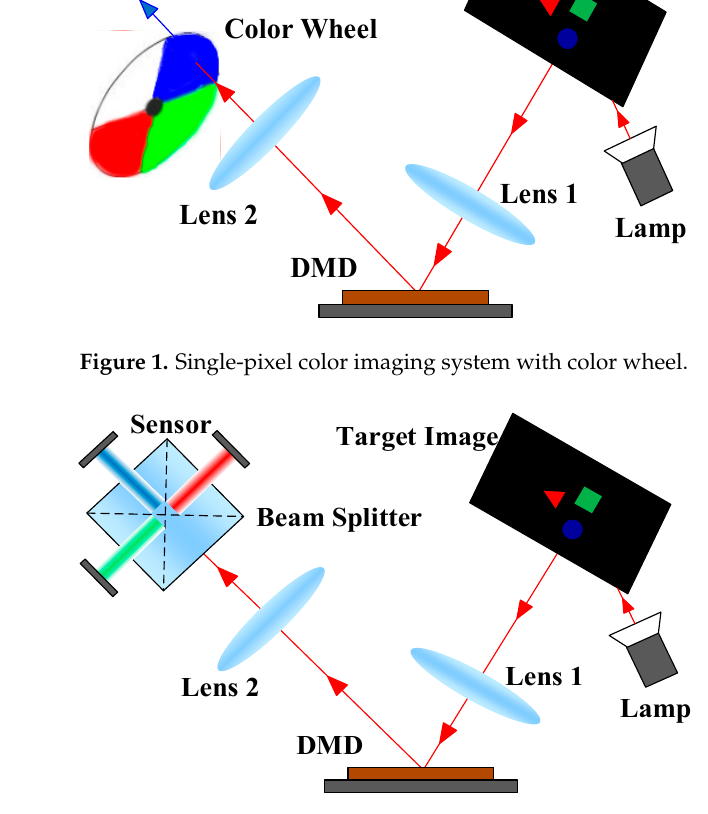
Figure 2. Single-pixel color imaging system with chromatic dispersion theory.